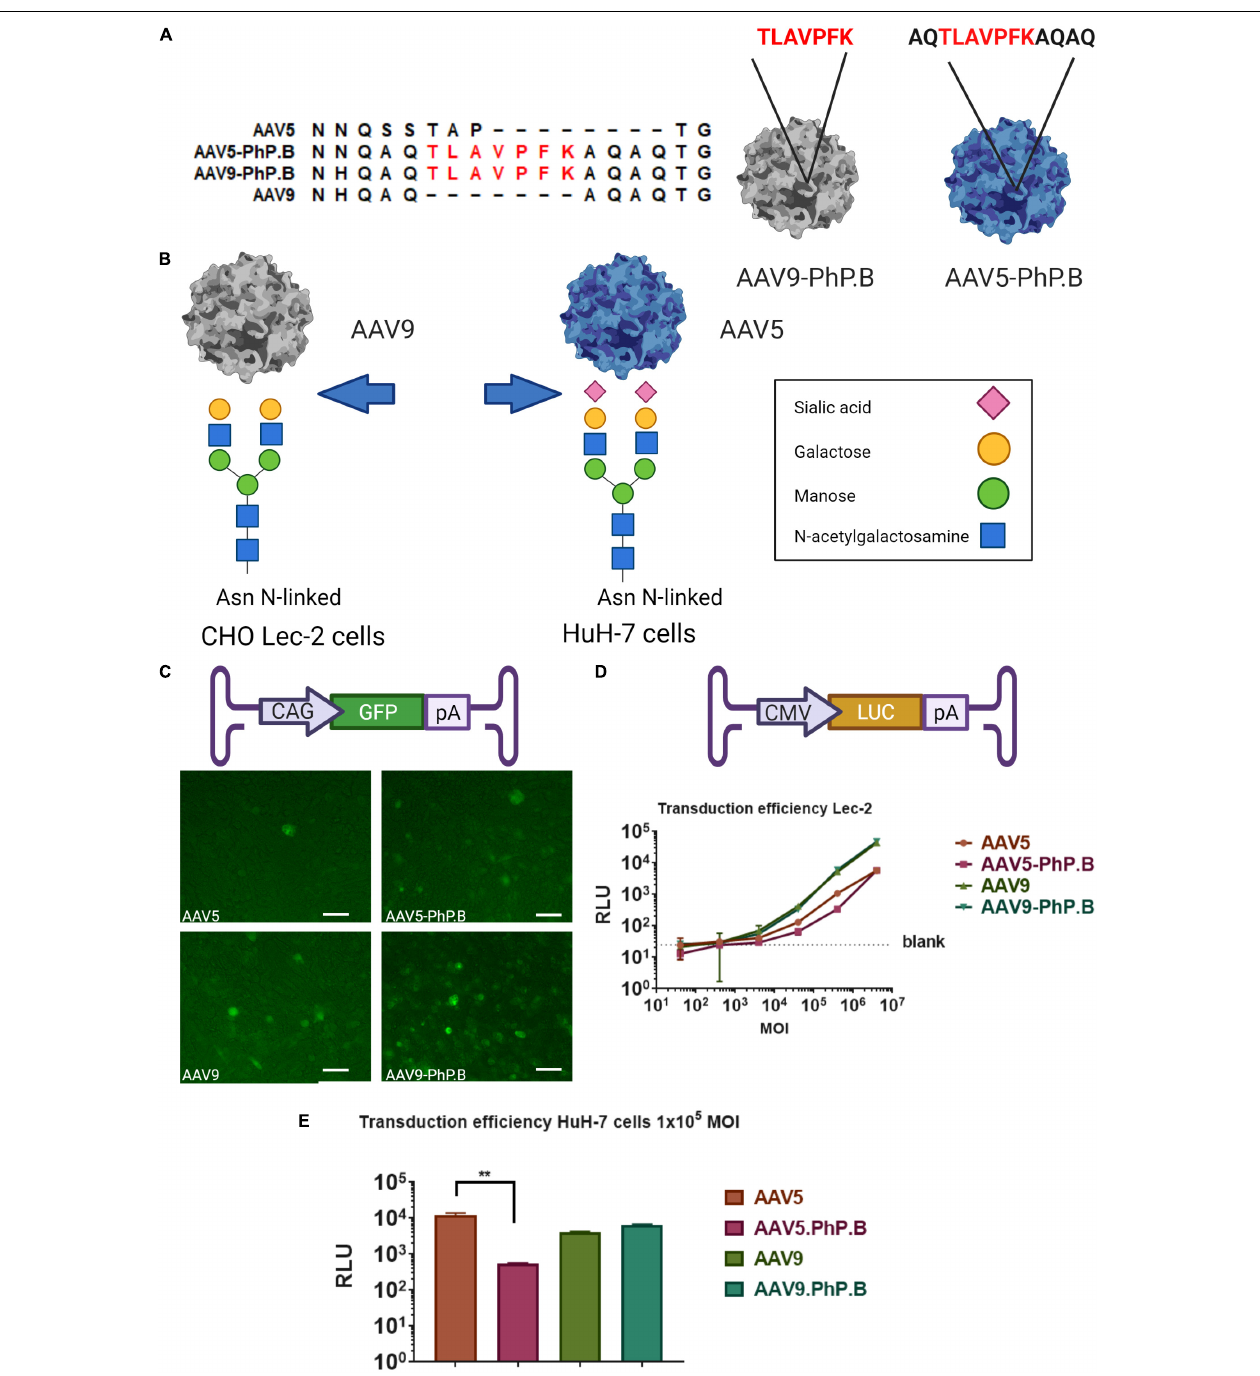
FIGURE 1 | Overview of AAV-PhP.B capsids and in vitro testing. (A) Alignment of AAV5, AAV5-PhP.B, AAV9, and AAV9-PhP.B at PhP.B insertion. (B) Binding by AAV9 of CHO Lec-2 cells due to the modification of the cell surface in glycan receptor exposing galactose, whereas AAV-5 transduces Huh-7 cells through binding to sialic acid. Receptors on the cell surface are depicted in this figure. (C) Schematic overview of the expression cassette containing the cytomegalovirus (CMV) early enhancer element and chicken beta-actin promoter (CAG), green fluorescent protein (GFP), and poly(A) tail. CHO Lec-2 cells were inoculated in triplicate with GFP encoding constructs of each capsid. All capsids are capable of inducing GFP expression at 7 days postinoculation. (D) Graphical representation of expression cassette used containing CMV-promoter-luciferase gene and poly(A) tail. A dose–response of each capsid in CHO Lec-2 cells measured as relative luminescence (RLU). A total of 2 × 10 4 cells/well were infected in a serial dilution starting at a multiplicity of infection (MOI) of 4 × 10 6 cells/well in a 96-well plate. (E) Inoculation of HuH-7 cells with AAV vectors. The addition of PhP.B to AAV-5 resulted in a decreased transduction in both cell types. Experiments were performed in triplicate in a 24-well plate, seeding 1 × 10 5 cells/well for HuH-7 cells. AAV5, orange bar; AAV5-PhP.B, pink bar; AAV9, light green; and AAV9-PhP.B, dark green. Asterisks indicate a statistical significance of p ≤ 0.005.